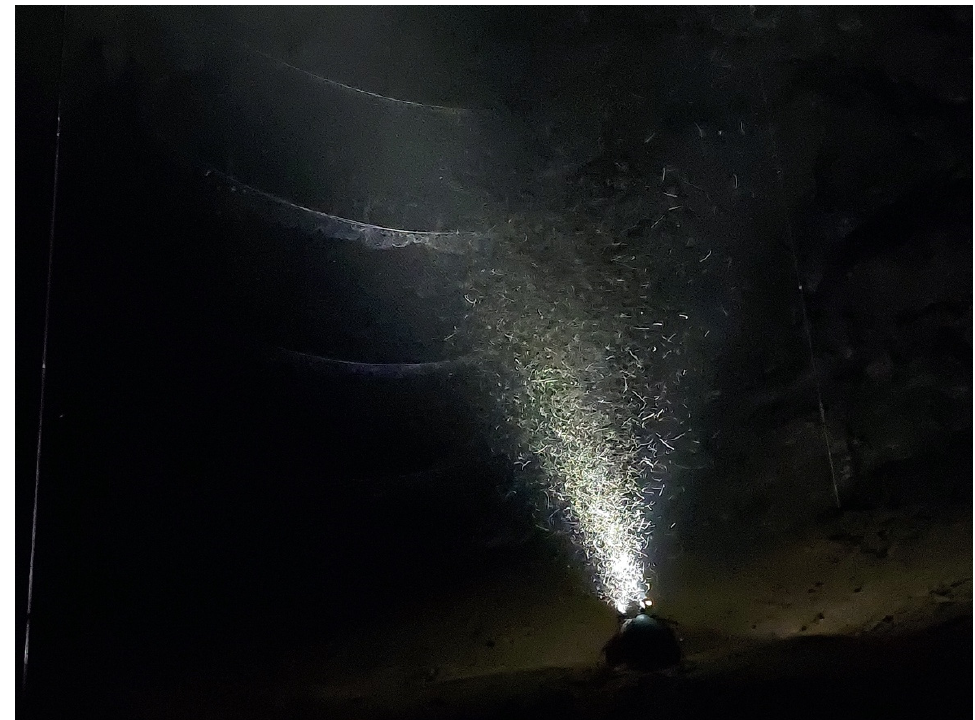
Figure 1. Mist netting at the site inside Son Doong Cave near doline 1.